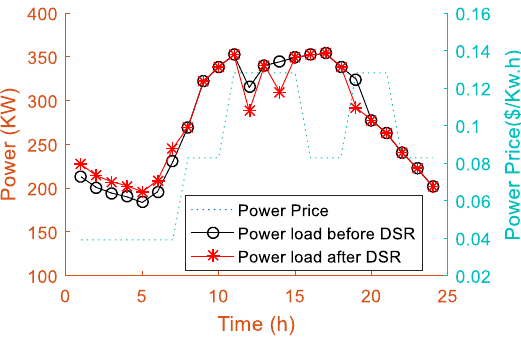
Figure 9. Power loads before and after DSR.